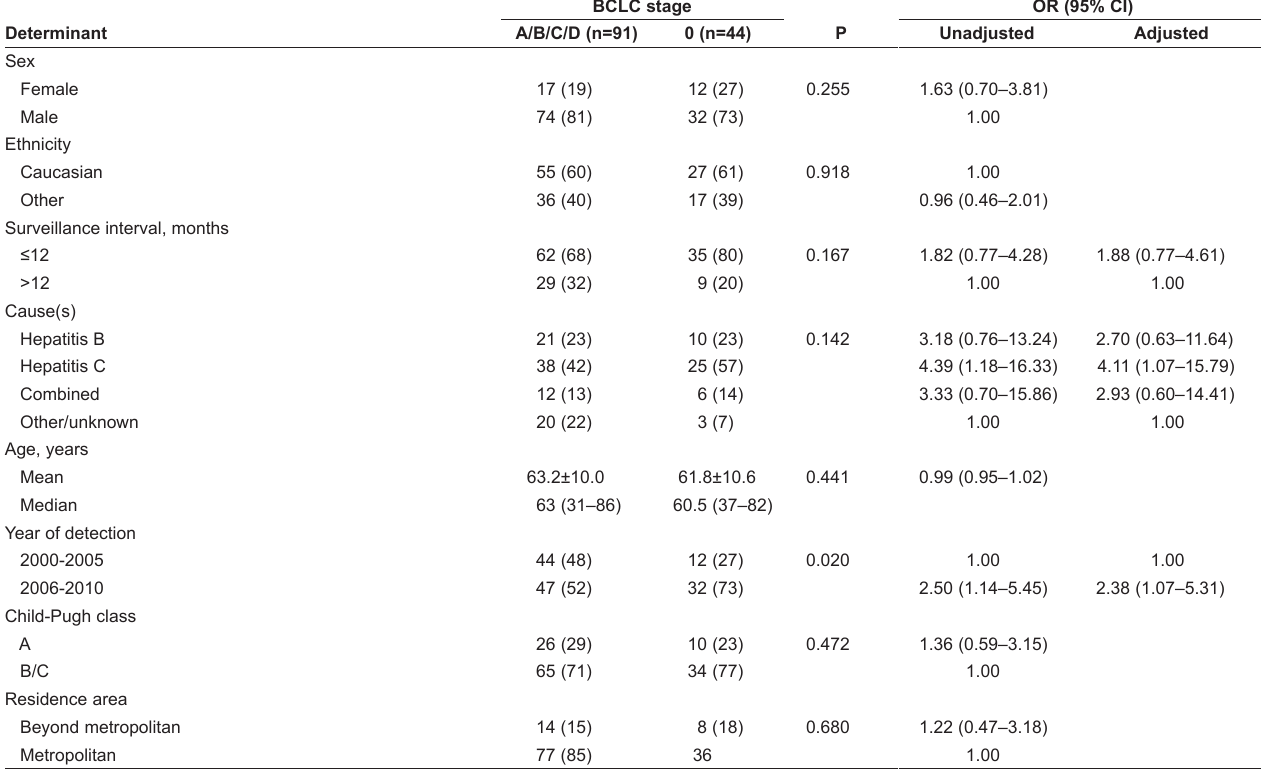
TABlE 7 Univariate analysis of potential determinants of success of hepatocellular cancer ultrasound surveillance in the detection of tumour in very early stage (Barcelona Clinic liver Cancer [BClC] stage 0)